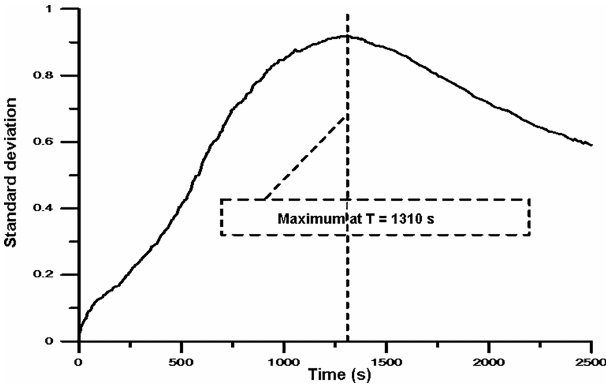
Figure 7. Time evolution of the relative standard deviation σ(S max ) of the mass of the largest droplet, for a finite system modeled with the hydrodynamic collection kernel. The initial distribution was bidisperse with 20 droplets of 17µm in radius and 10 droplets of 21.4µm in a volume of 1cm 3 . The maximum of σ(S max ) was found at